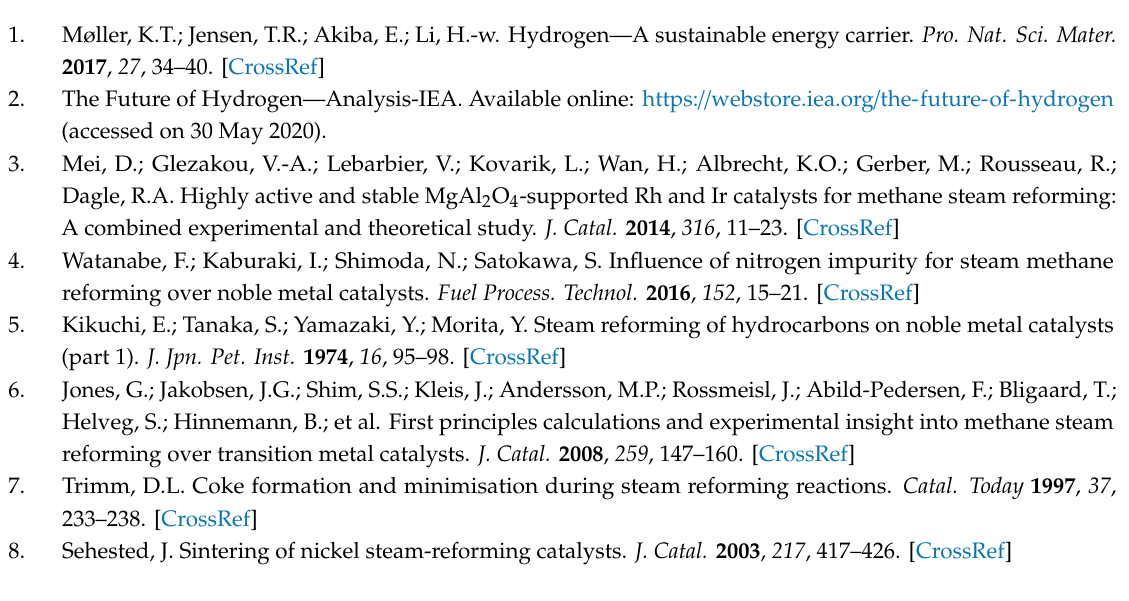
Figure S1: TEM images of mesoporous Mg-aluminate calcined at 600 ◦ C: (a,e) Mg9, (b,f) Mg19, (c,g) Mg25, (d,h) Mg30, Figure S2: TGA-DSC analysis of catalysts after reaction under harsh conditions: (a) Ni / Mg9, (b) Ni / Mg19, (c) Ni / Mg25, and (d) Ni / Mg30, Table S1: Pore structure analysis of mesoporous Mg-aluminate supports, after Ni loading with calcination and after reduction, Table S2: JCPDS card information of main peaks, Table S3: The temperature di ff erence between inside of the catalyst bed and outside of the reactor during the